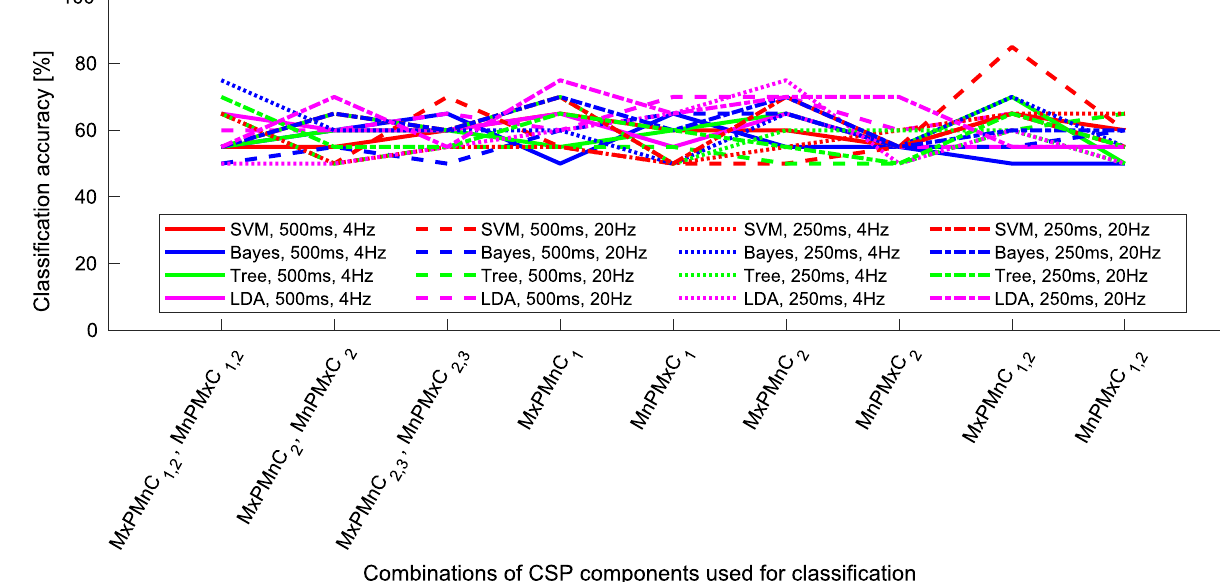
Figure 1. Classification results of the validation set when different parameters for feature extraction and classification were used when using the CSP. Shown are results when the upper frequency of the band-pass filter was 4 Hz or 20 Hz, the length of interval was 250 ms or 500 ms, the classifier used was either SVM RBF , Bayes, Decision Tree or LDA, for different combinations of CSP components. On x-axes are plotted combinations of channels, where MxPMnC l denotes selected components ( l ) with maximized variance for PD group and minimized variance for control group, while MnPMxC l denotes selected components ( l ) with minimized variance for PD group and maximized variance for control group. For better visibility results for only selected values for upper band frequency and interval length are presented. Omitted are also the results obtained with SVM classifier with polynomial kernel and QDA classifier, since the results were similar to those obtained using the SVM RBF and LDA, respectively, although generally lower. Figure was created using Matlab 2020b (https:// www. mathw orks. com/ produ cts/ matlab.